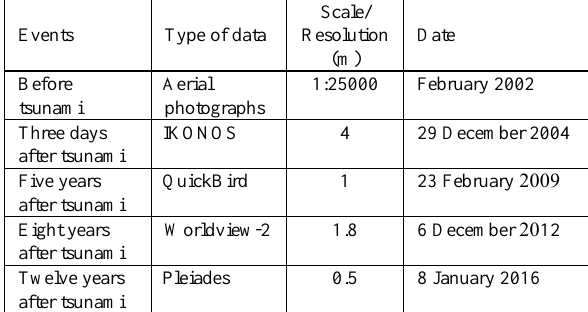
Table 1 Data used for coastal